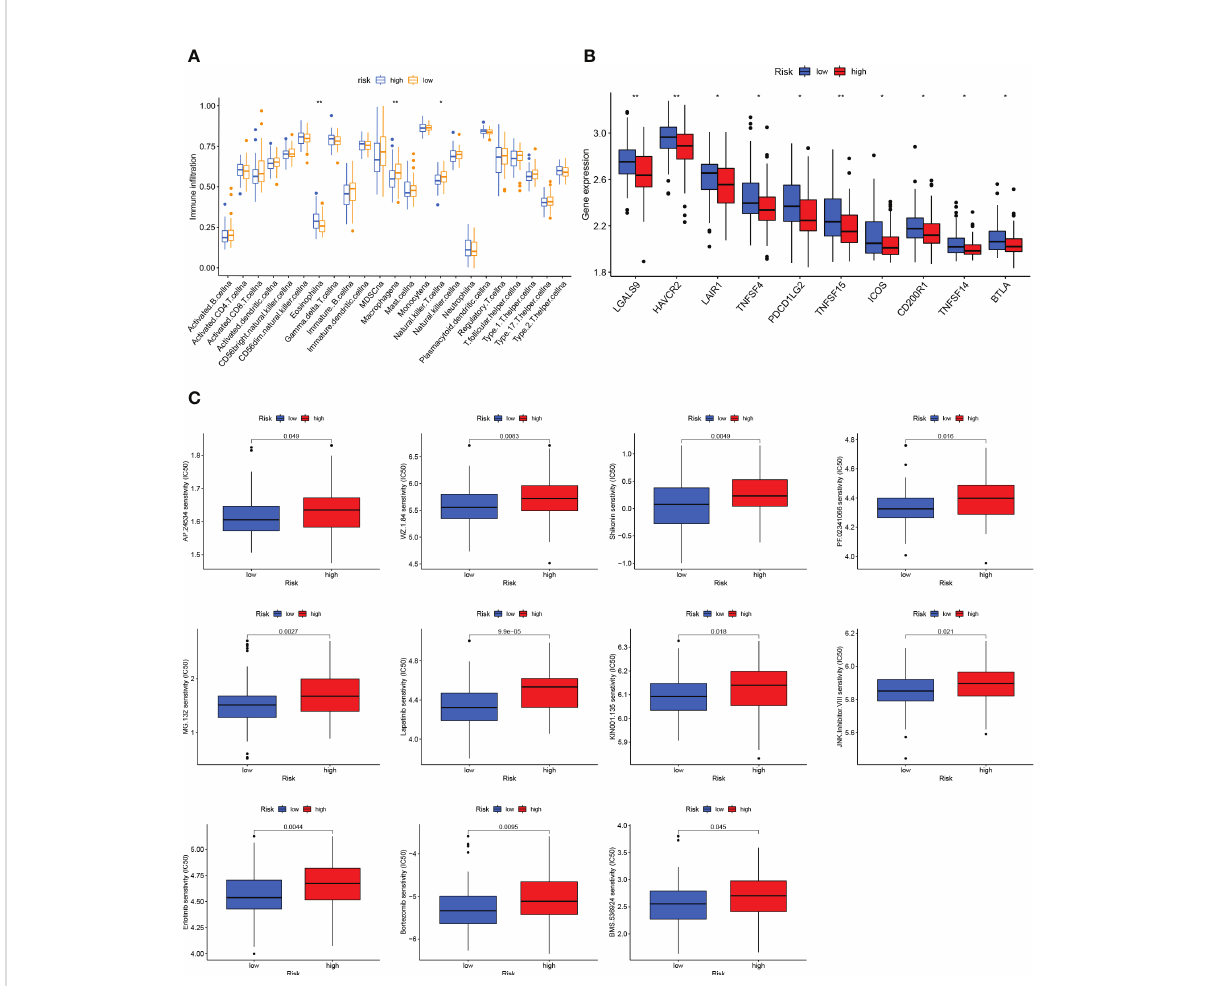
FIGURE 7 Immune status and drug sensitivity differences between high- and low-risk groups. (A) Comparison of immune cell in fi ltration between the high-risk group and low-risk group. (B) Comparison of the expression of immune checkpoints between the high-risk group and low-risk group. (C) Drug sensitivity in the high-risk group and low-risk group. *P < 0.05, **P <